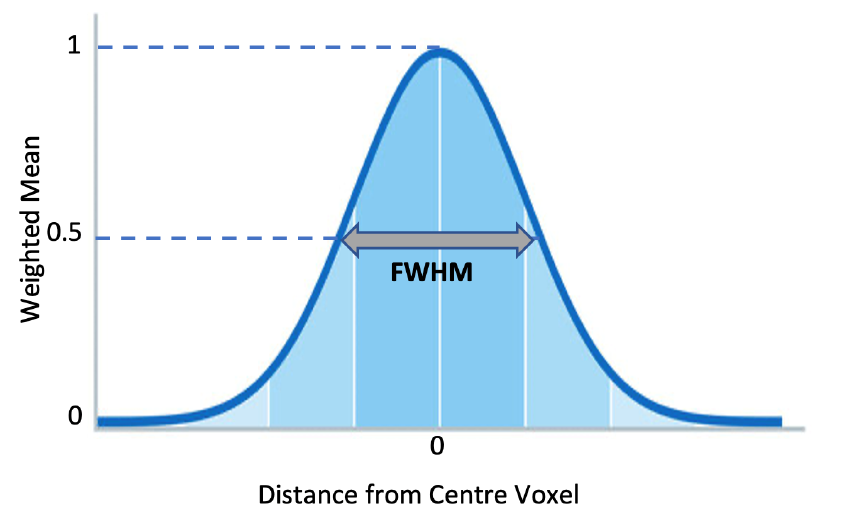
Figure 7. Gaussian Smoothing Kernel.